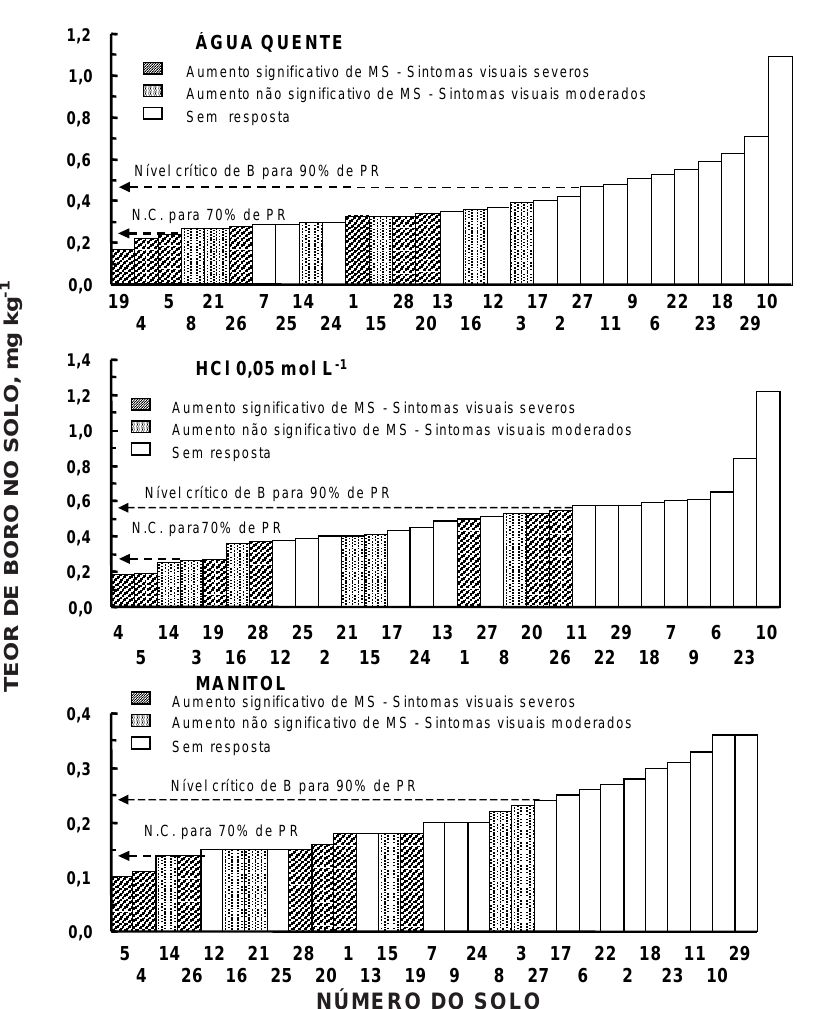
Figura 2. Comparação dos teores de boro nos solos originais extraídos pela água quente, HCl 0,05 mol L -1 e manitol 0,05 mol L -1 + CaCl 0,01 mol L -1 com as respostas do girassol na produção de matéria seca 2 (MS) e nos sintomas visuais de deficiência do primeiro cultivo.